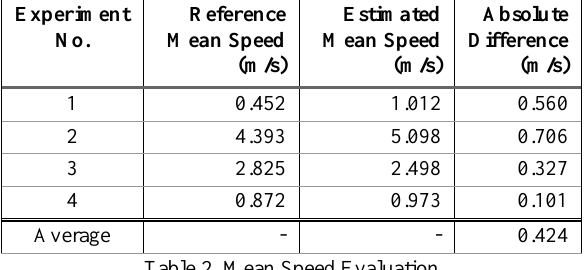
Table 2. Absolute difference in mean speed give general indication of result quality over the whole monitoring period.